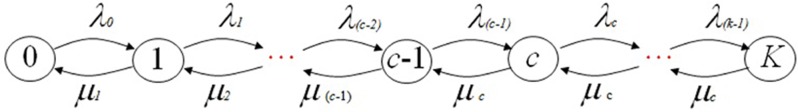
State-transition-rate Diagram.